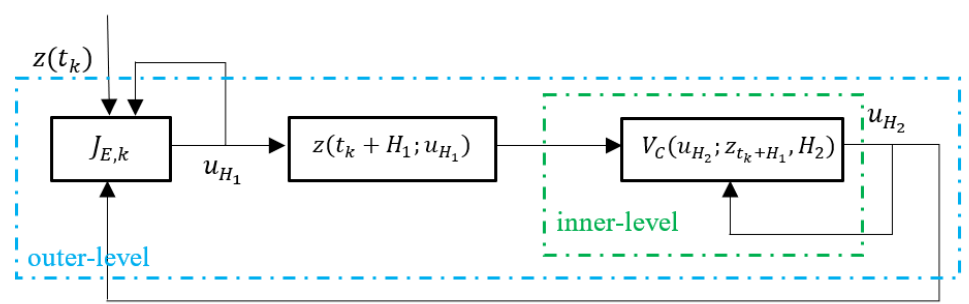
Figure 6. The nested structure of Efficiency-oriented Model Predictive Control.